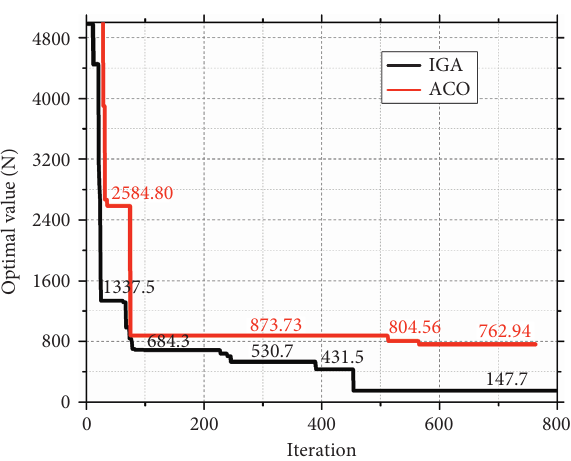
Figure 8: Comparison between IGA and